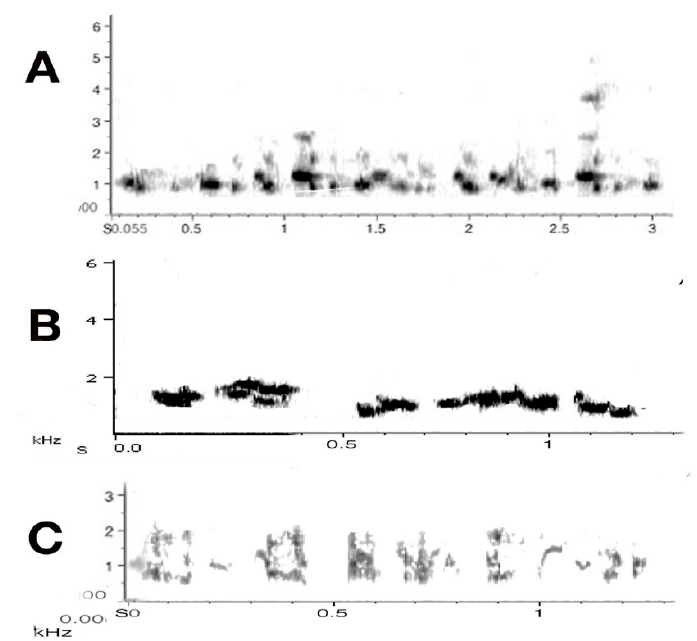
Figure 3. Adult and juvenile warble songs. Y-axis: frequency in kHz, X-axis: time in seconds. ( A ) Upper-panel: typical song/warble sequence by an adult. ( B ) An enlarged version of the same (1 s excerpt). ( C ) Enlarged 1 s of a juvenile warble, still revealing recognizable structures in elements and syllables. Warbles are produced in a narrow frequency band, as ( B ) shows, and have relatively few or any overtones (harmonics). Such songs can be performed for hours [2,23]. The magpie’s